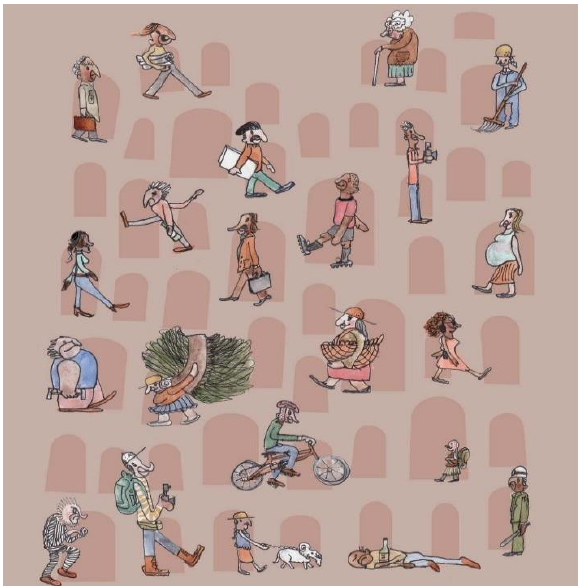
Figure 3. Comic characters "The Adventures of Don Victor". Source: Photographic Repository of the Ciudad Patrimonio Mundial